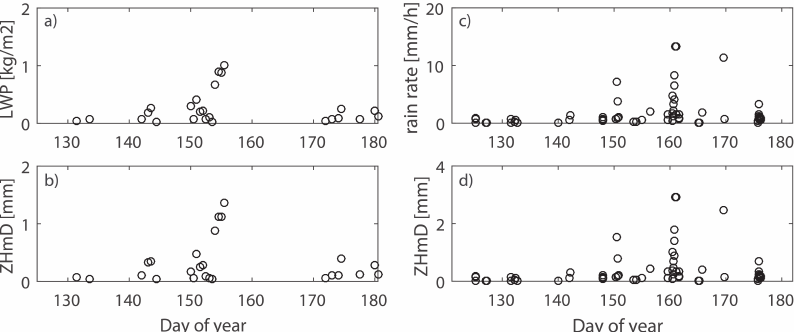
Figure A2. Hydrometeors’ content induced by ( a ) liquid water expressed in terms of LWP and ( c ) MPE rain rate with their respective contributions to zenith delays ( b , d